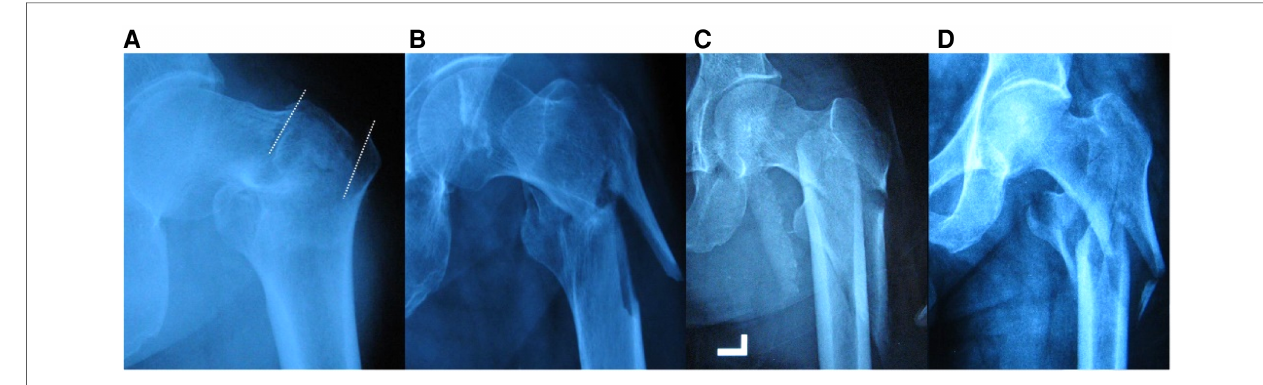
FIGURE 5 Representative radiographs. ( A ) Type ID(AB) fracture that cannot be classi fi ed in AO. It is a fracture with intact medial cortex and two lateral penetrating lines (white dotted line). ( B ) Type ID(AC) fracture that cannot be classi fi ed in AO. ( C ) Type ID(BC) fracture that cannot be classi fi ed in AO. ( D ) A3.3/IIID(AC)